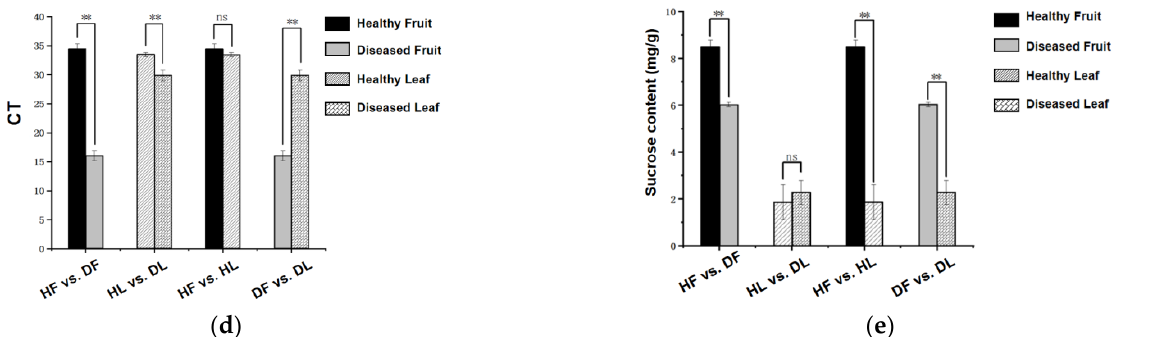
Figure 1. Huanglongbing (HLB) symptomatology and characteristics on the leaf and fruit samples of Citrus reticulata Blanco ‘Shatangju’ affected by HLB. ( a ) Healthy (up) and CLas-infected (down) fruit samples. ( b ) The average weight of the fruits. ( c ) The average diameter of the fruits. ( d ) Quantitation of CLas in the leaf and fruit samples. ( e ) Sucrose content (mg/g fresh weight) of the leaf and fruit samples. HLs indicate leaf samples of healthy ‘Shatangju’. HFs are fruit samples of healthy ‘Shatangju’. DLs are leaf samples of ‘Shatangju’ with HLB. DFs are fruits samples of ‘Shatangju’ with HLB. All data are presented as means ± standard deviation of the mean (Sd). The data were subjected to statistical analysis by one-way analysis of variance (ANOVA) using SPSS 13.0 software (** indicates p < 0.01, ns indicates there is no significant